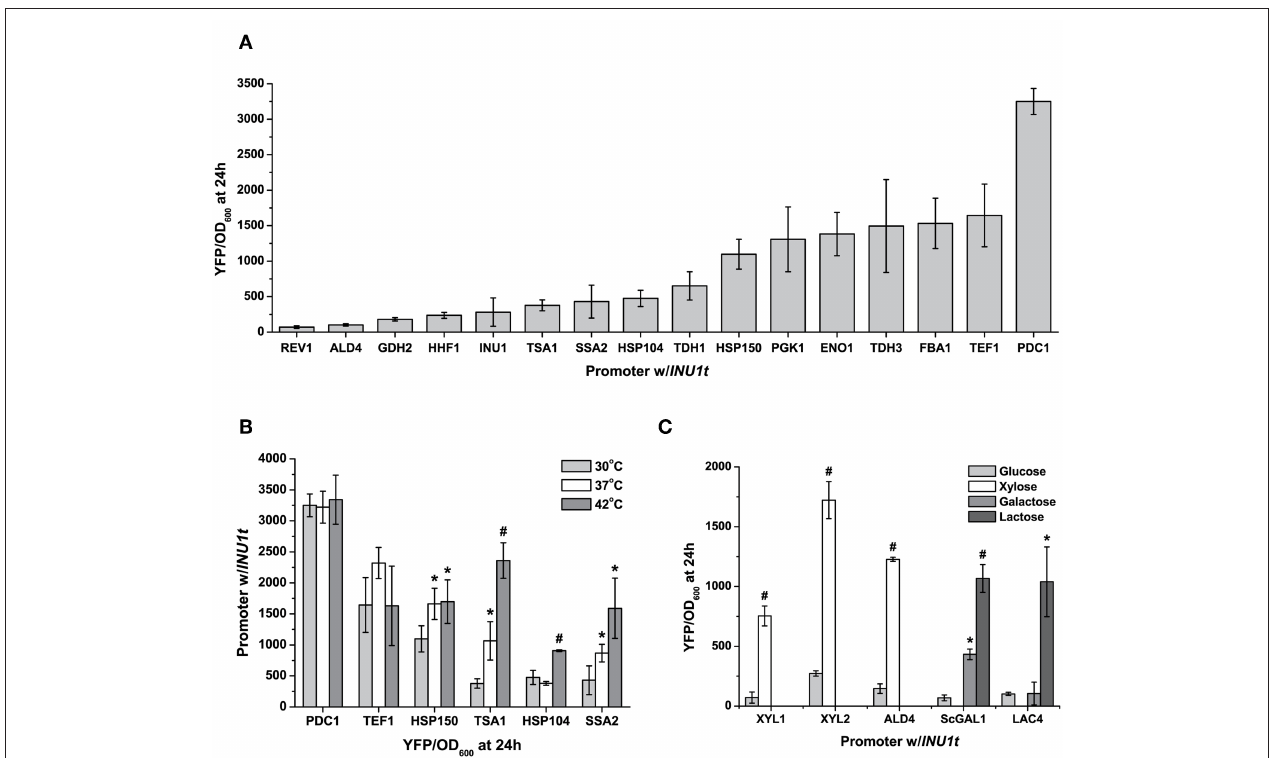
FIGURE 2 | Characterization of K. marxianus promoters. (A) A set of constitutive promoters, taken from genes with diverse functions, provide a wide range of expression levels—nearly two orders of magnitude—as seen from the YFP output under standard conditions (24h at 30 ◦ C, 2% glucose in synthetic complete medium) (B) Expression of heat-inducible promoters at three different temperatures at which NBRC1777 can grow. Constitutive promoters as well ( PDC1pr ) have a stable output at high temperatures. (C) The diverse carbon source utilization of K. marxianus gives us a unique induction signal for this yeast, as seen by the induction of promoters by lactose, galactose, and xylose. All data are normalised to cell number using OD, and are plotted as the mean ± s.d. of at least three replicates. YFP values significantly different from those under baseline conditions (30 degrees in drop-out medium with 2% glucose) are marked with an asterisk ( p < 0.05) or a hash ( p <